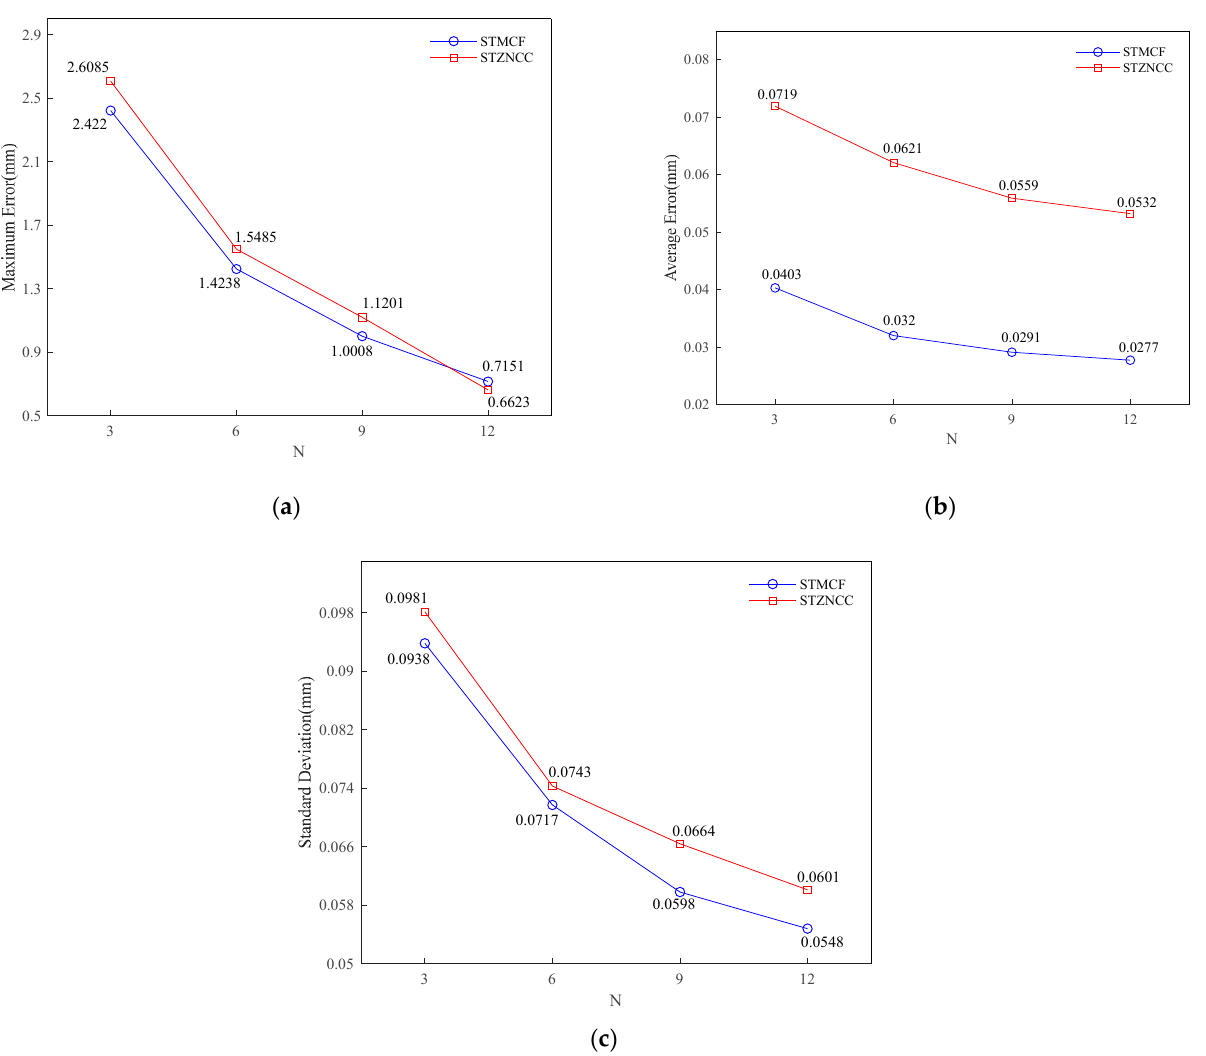
Figure 7. Error statistics comparison between STZNCC and STMCF of measuring a plastic human face mask. ( a ) maximum error; ( b ) average error; ( c ) standard deviation.